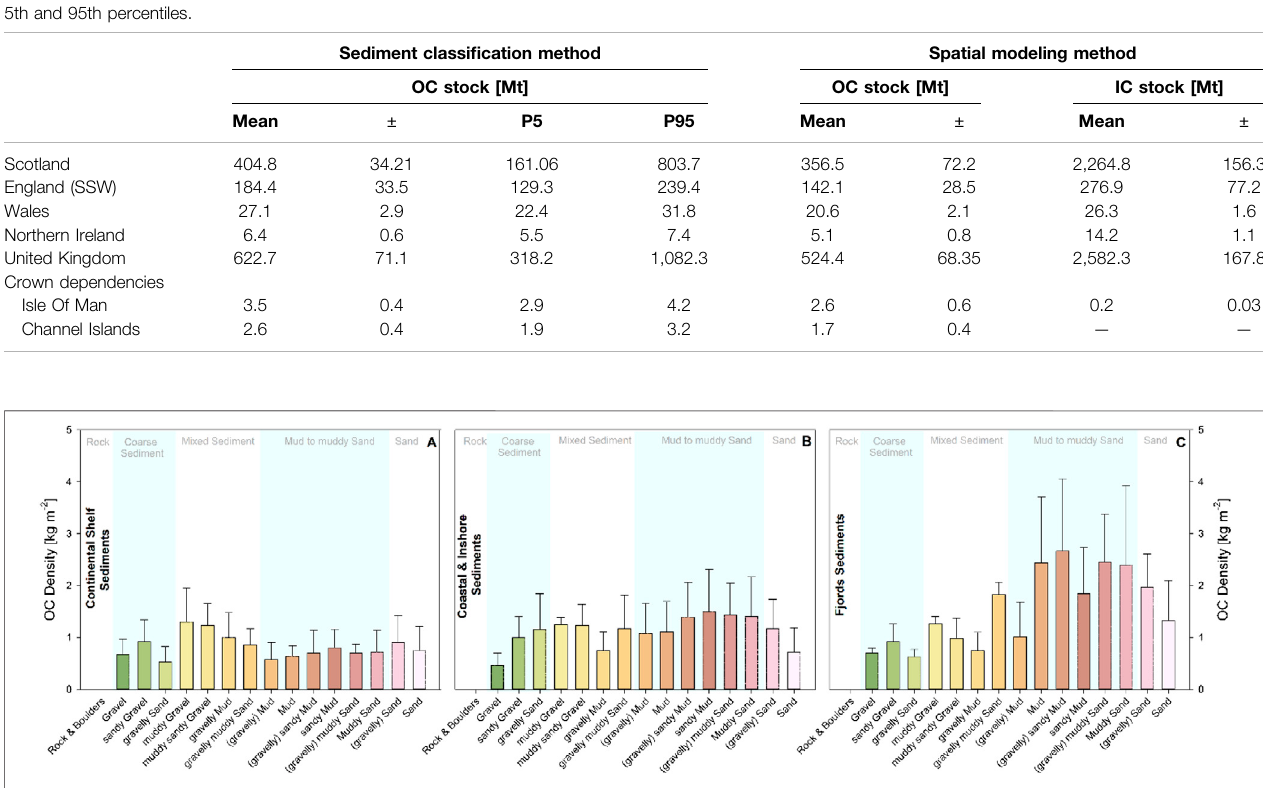
FIGURE 8 | Mean OC density [kg m − 2 ] of the 16 sediment classes across the three UK EEZ zones (A) Continental shelf ( and shelf slope and deep sea zone ) (B) Coastal and inshore (C) Fjords.